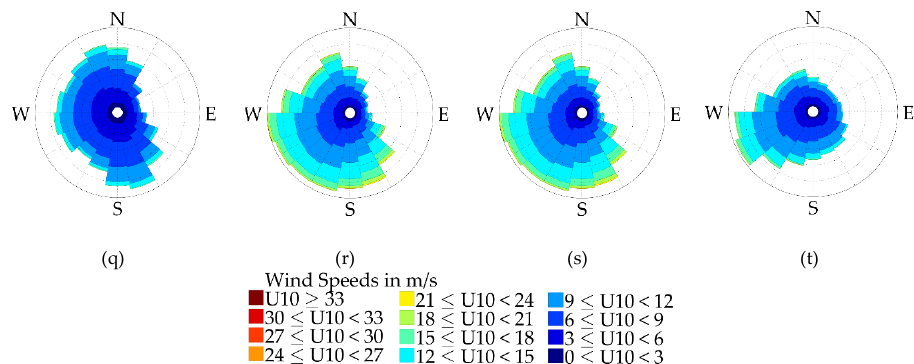
Figure 10. Wind roses corresponding to the two seasons (winter and summer), resulting from processing the data for the 35-year period considered. The results are provided for ten of the most representative locations, one for each geographical zone targeted. ( a ) summer season-A3; ( b ) winter season-A3; ( c ) summer season-B1; ( d ) winter season-B1; ( e ) summer season-C4; ( f ) winter season-C4; ( g ) summer season-D3; ( h ) winter season-D3; ( i ) summer season-E3; ( j ) winter season-E3; ( k ) summer